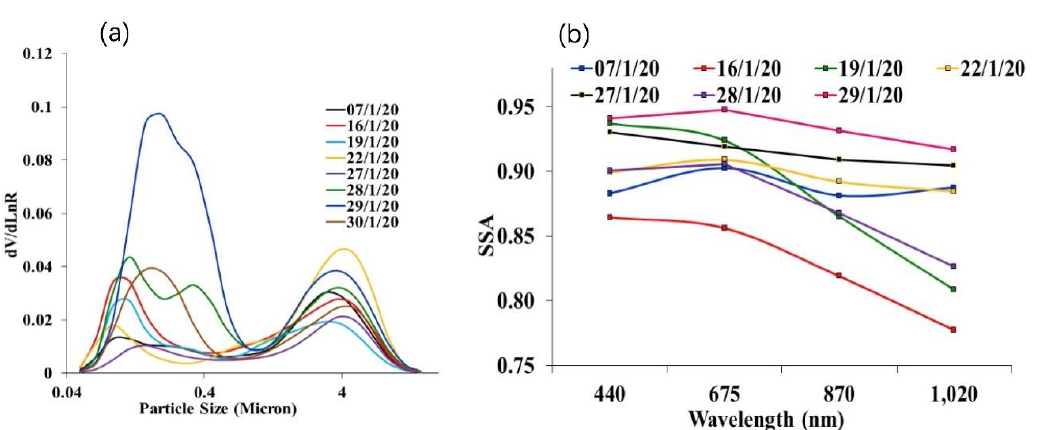
Figure 7. ( a ) The volume size distribution of aerosols. ( b ) Wavelength dependence of single scattering Figure 7. a. The volume size distribution of aerosols. b. Wavelength dependence of single scattering albedo (SSA) over Manila AERONET station during January albedo (SSA) over Manila AERONET station during January 2020.